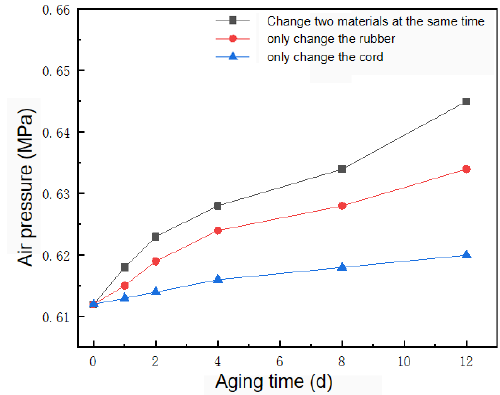
Figure 9. Comparison of air pressure with aging time.